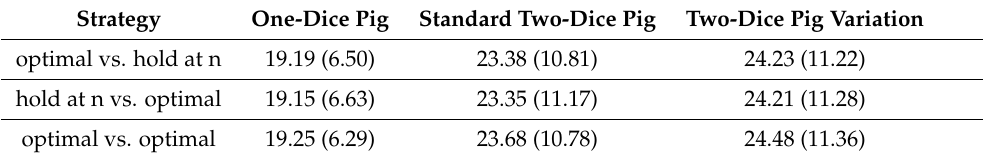
Table 1. The average number of turns played in different strategy combinations, simulated by 10,000,000 games. Numbers in the parenthesis are the standard deviations. The choice of n is determined by the best n in each scenario. For one-die Pig, n = 25; for standard two-dice pig, n = 23; for “Double Trouble”, the two-dice Pig variation, n = 18. Strategy One-Dice Pig Standard Two-Dice Pig Two-Dice Pig Variation optimal vs. hold at n hold at n vs. optimal optimal vs.